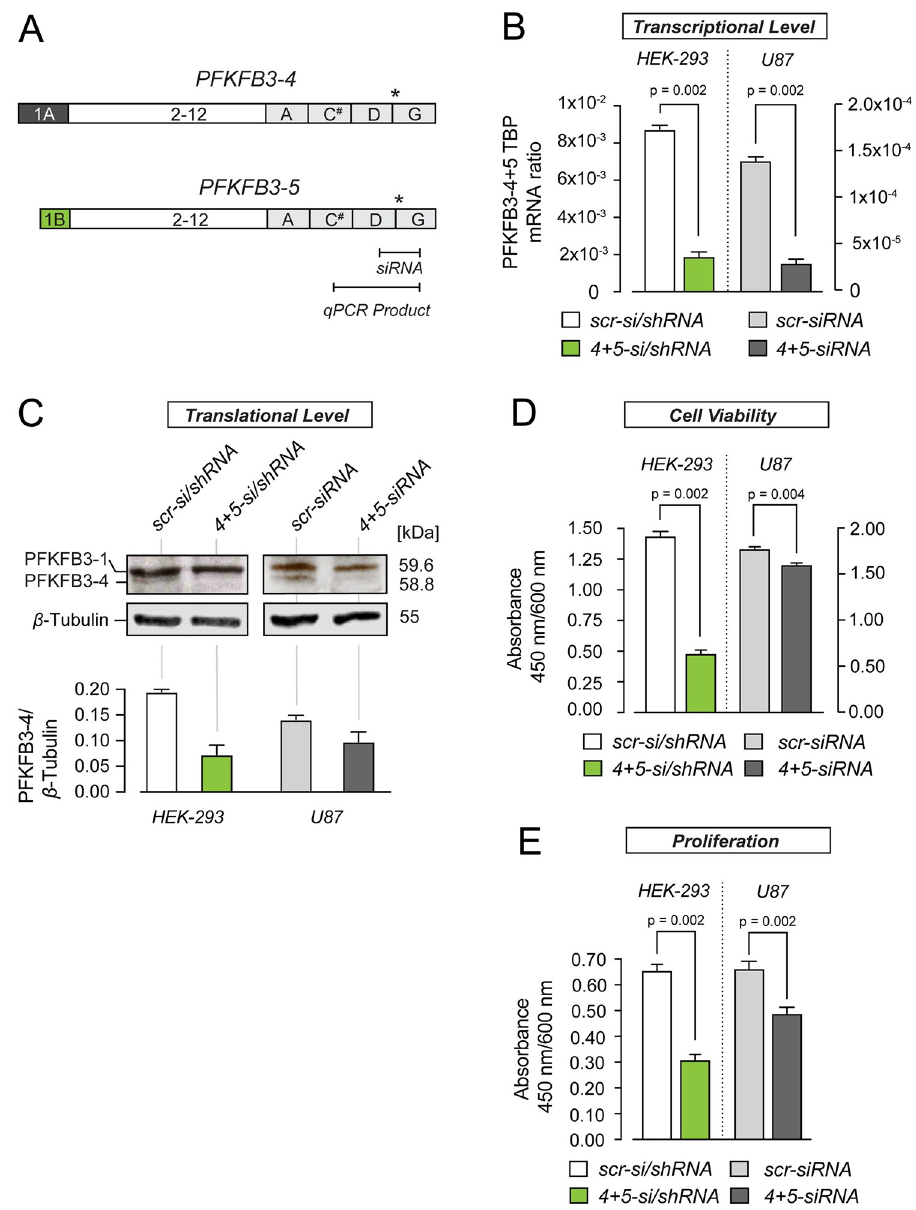
Fig 2. Knock-down of PFKFB3-4+5 alters proliferation and viability of HEK-293 and U87 cells. (A) Schematic representation of PFKFB3-4 and - 5 with indication of PCR/qPCR as well as siRNA target sequences. Note that PFKFB3-4 and -5 differ in their N- but not C-termini. � indicates the stop codon, # indicates the predicted nuclear localization signal (NLS). siRNA probes used for gene silencing recognize sequences between exons D and G, in PFKFB3-4 and PFKFB3-5. (B) Quantification of stably and transiently inhibited PFKFB3-4+5 expression in HEK-293 and transiently inhibited PFKFB3-4+5 in U87 cells, respectively. The RNAi sequence for siRNA was identical to that of shRNA. mRNA levels in cells transfected with PFKFB3-4+5 si/shRNA was compared to scr-si/shRNA-transfected cells. mRNAs were detected 24 h after siRNA treatment. PFKFB3-4+5 expression was normalized to the amount of TBP mRNA measured by quantitative PCR. mRNA-based experiments were done as duplicates in 3 independent experiments (N = 3, n = 2). The values represent the mean ± SEM. (C) Western blot analysis of PFKFB3 protein expression following si/shRNA mediated PFKFB3-4+5 knock-down utilizing polyclonal PFKFB3 antibody. Proteins were detected 48 hours after siRNA treatment. β -Tubulin served as loading control. 30 μ g protein/lane was applied. Western blot shows the 58.8 kDa band in scr-si/shRNA cells. The ratio of protein bands (PFKFB3-4/5 to β -Tubulin) was calculated from the intensity values of protein bands (n = 3). (D) Quantification of cell viability of PFKFB3-4 +5-depleted HEK-293 and U87 cells compared to scr-si/shRNA treated cells via WST-1 assay. After a 4 h